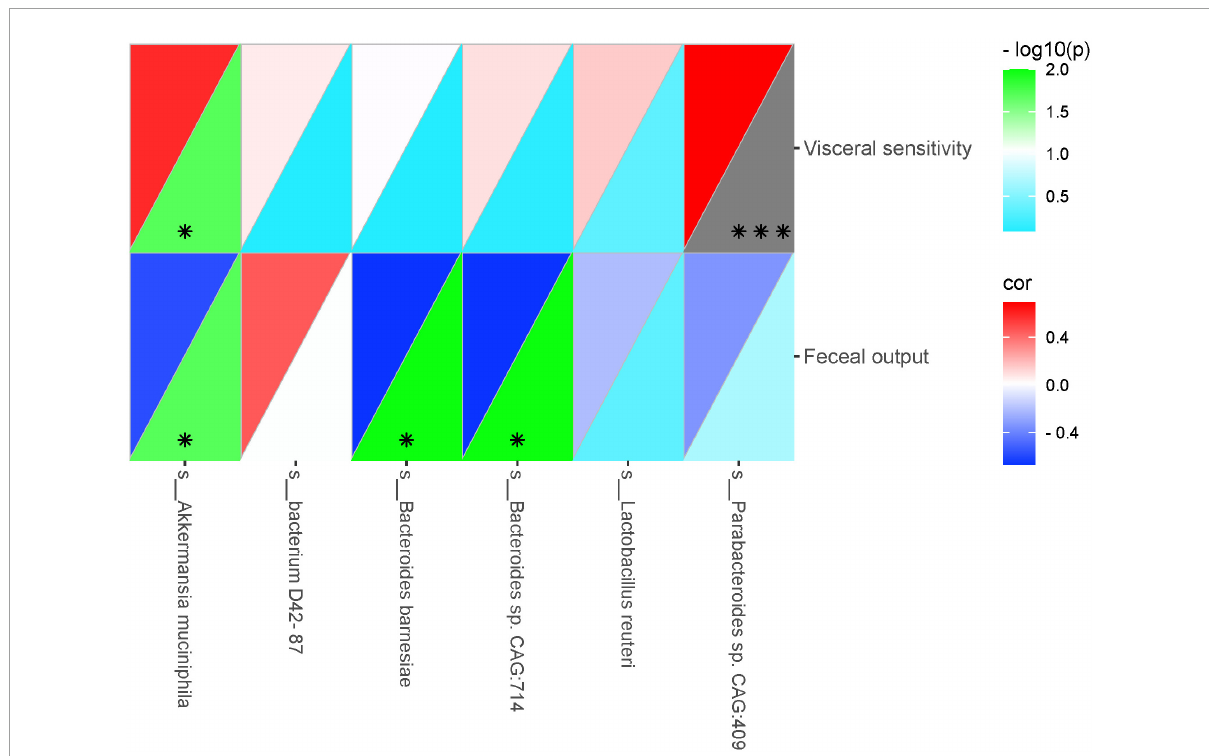
FIGURE6 Heatmap showing correlations between significantly altered intestinal microbiota and rat phenotype parameters. Color intensity indicates the degree of correlation. The top left represents the correlation, and the bottom right represents –log10( P ). Red, positive correlation; blue,